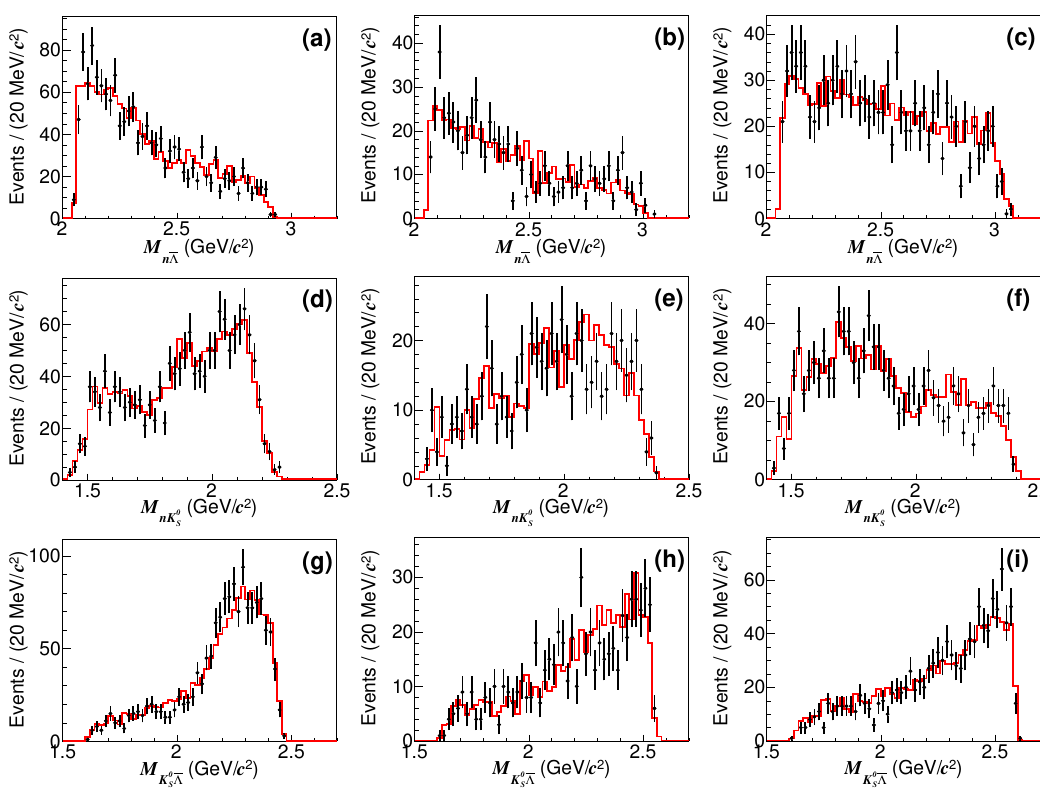
¯Λ + c . c . ( J = 0 , 1, 2). The 0 S